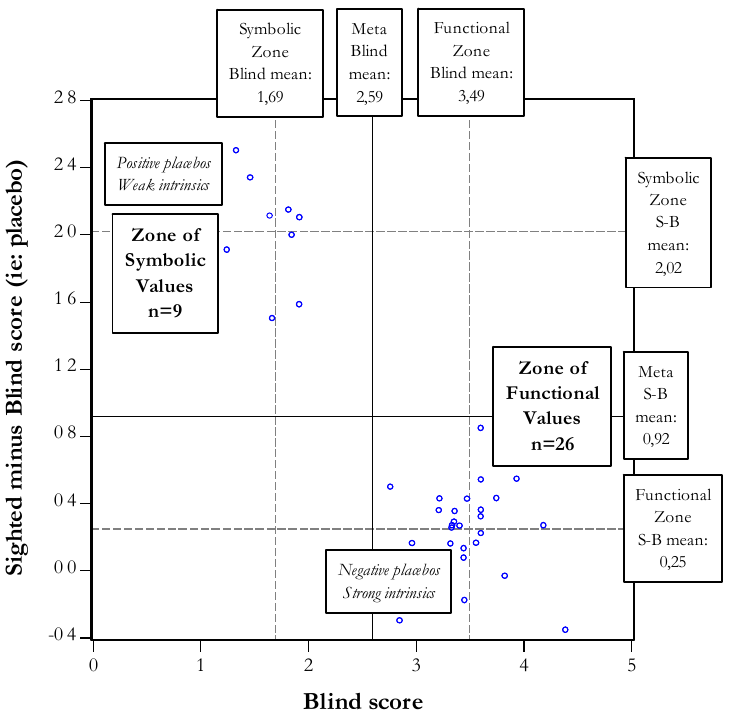
Figure 2: The distribution of zones of symbolic and functional value within a sub-set of brands with both functional and symbolic effects. The smaller Zone of Symbolic Values is characterised by weak intrinsic ( -ve functional b ’s); while the second, larger Zone of Functional Values presents the opposite: a span of negative placebos ( +ve symbolic b 2 ’s) coupled with strong intrinsics ( +ve functional b placebos ( -ve symbolic b 2 Stand-out exemplars appear with their respective predicted blind score and placebo differential in parenthesis: Jordan Cobblers Hill (4,19, 0,27), Ernie Els Wines (3,94, 0,54), Morganhof Premier Selection (3,61, 0,54), Rust en Vrede (3,75, 0,43), and Vergelegen V (3,60, 0,85). (Note: respective wine prices are also factored into the placebo